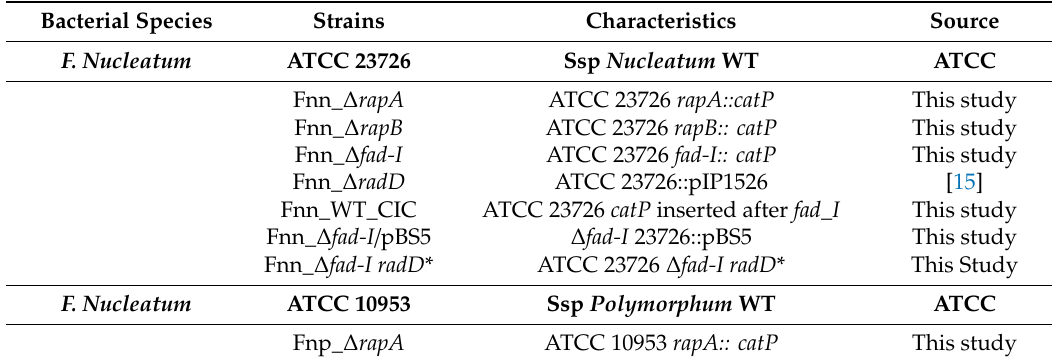
Table 1. Bacterial strains and plasmids used in the